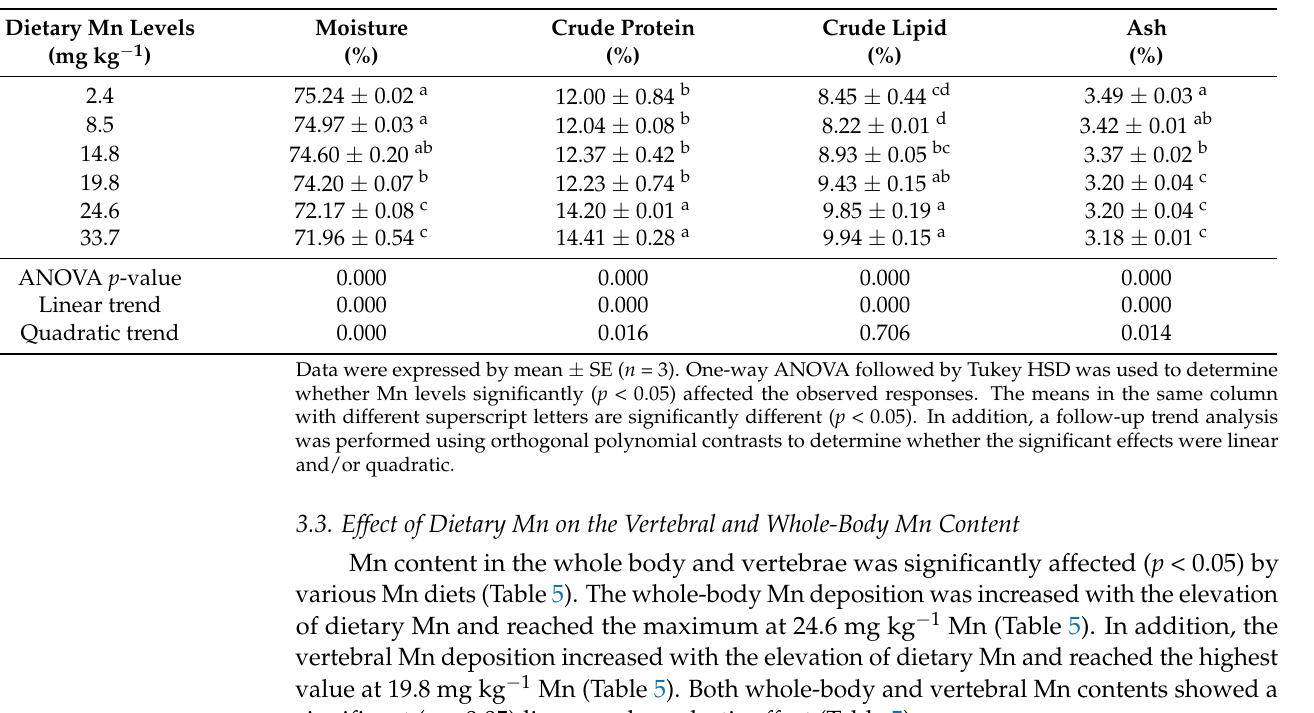
Table 4. Whole-body composition of post-larval coho salmon fed a diet with different levels of manganese.